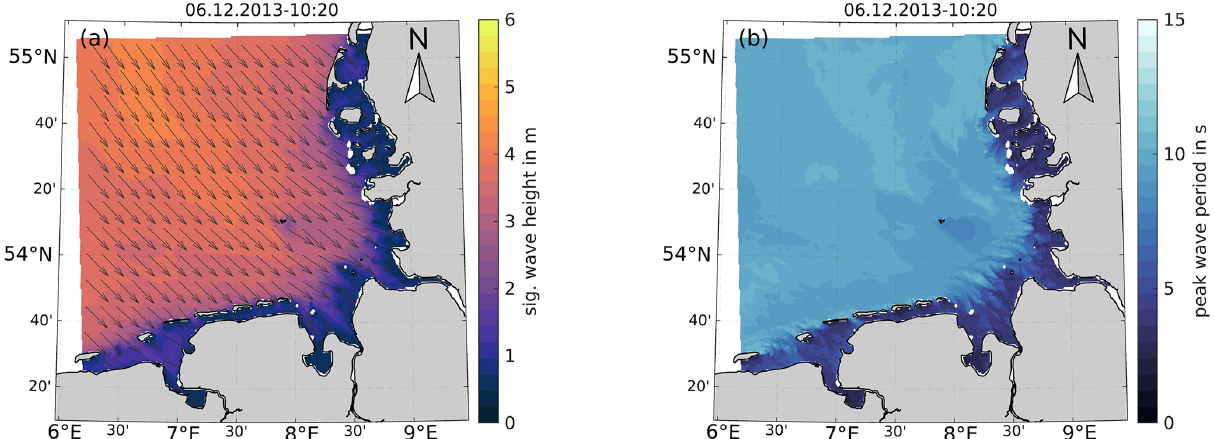
Figure 7. Exemplary sea state during the storm Xaver in 2013 showing significant wave height H m0 in meters and the mean wave direction (cid:50) m (a) and the peak wave T p period in seconds (b) in the EPZ. Note that the mean wave direction vectors in (a) are normalized.